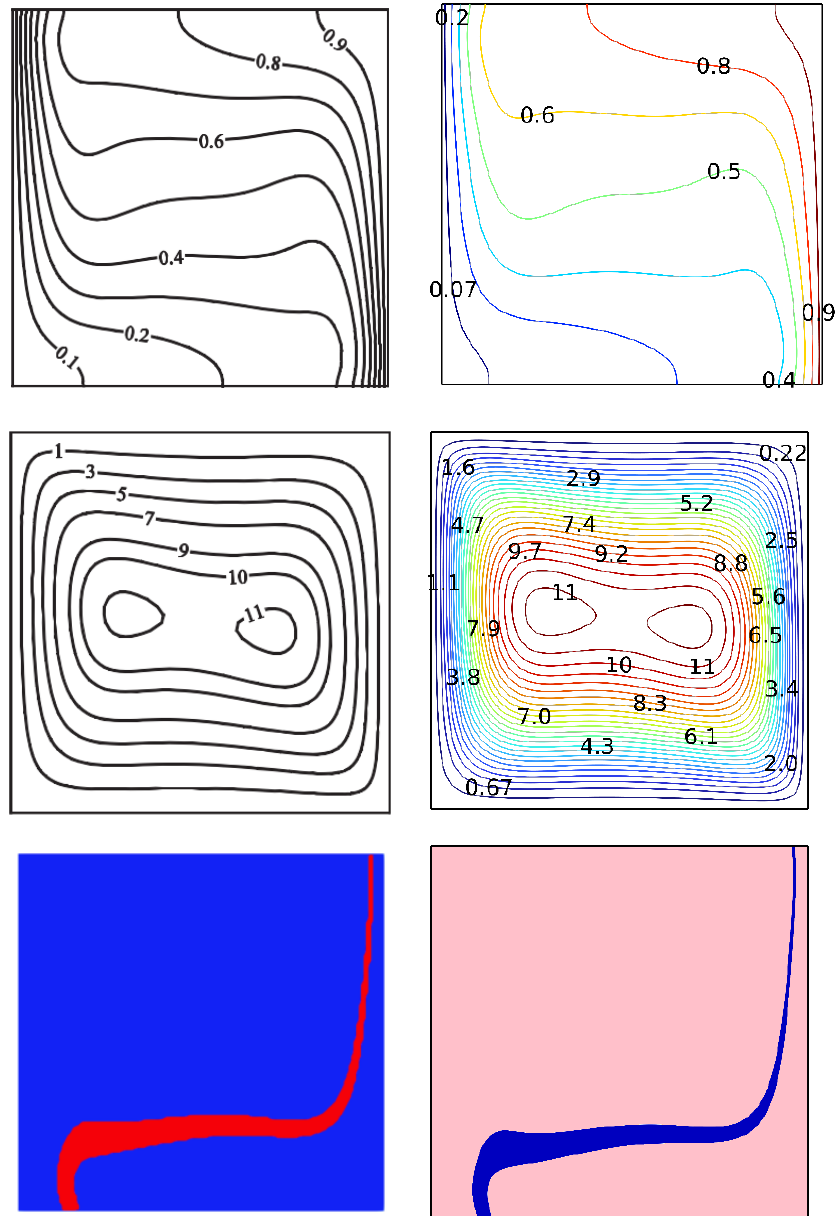
Figure 2. Comparison of current work with that of Mohammad Ghalambaz et al. reprinted/adapted with permission from Ref. [44]. 2022, Elsevier .